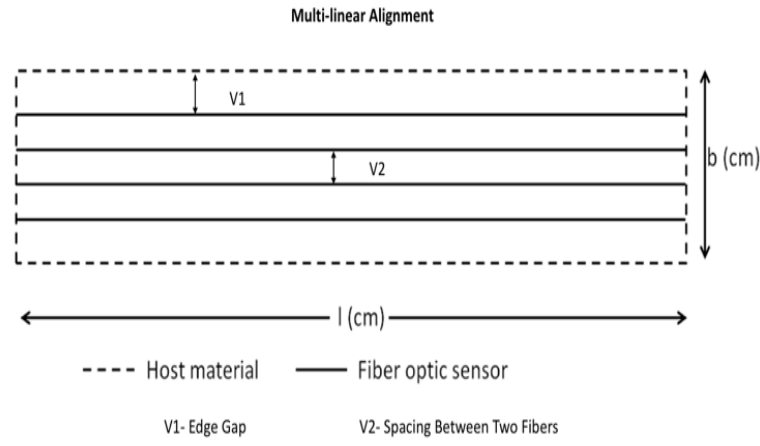
Figure 3 . Multiple FOSs embedded in linear alignment showing variables to optimise.